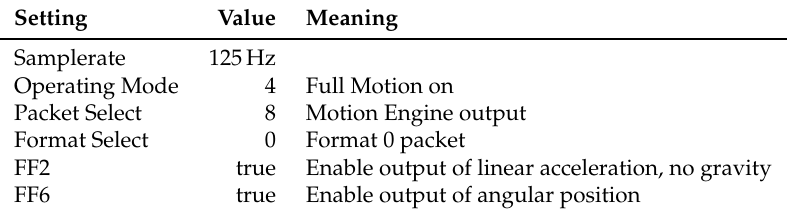
Table 1. Settings of the Hillcrest FSM-9.